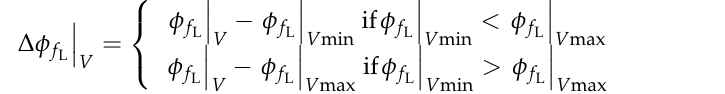
Table 1. Calculated PSR and in-band PD with Z Ho , Z Hs , and C v . Z Ho [ Ω ]